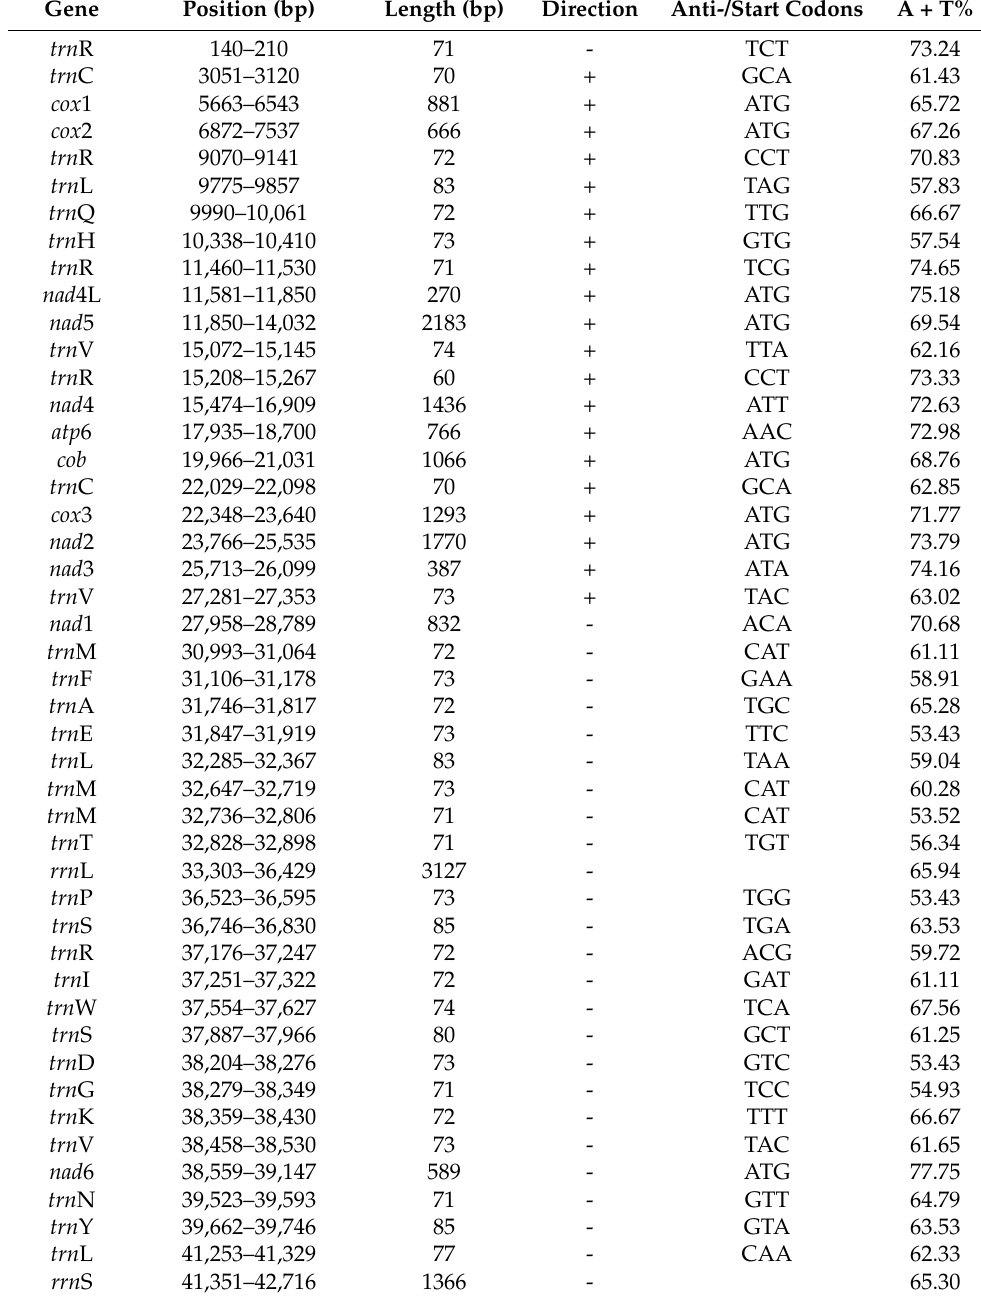
Table 1. Mitochondrial genome components of Paraconiothyrium